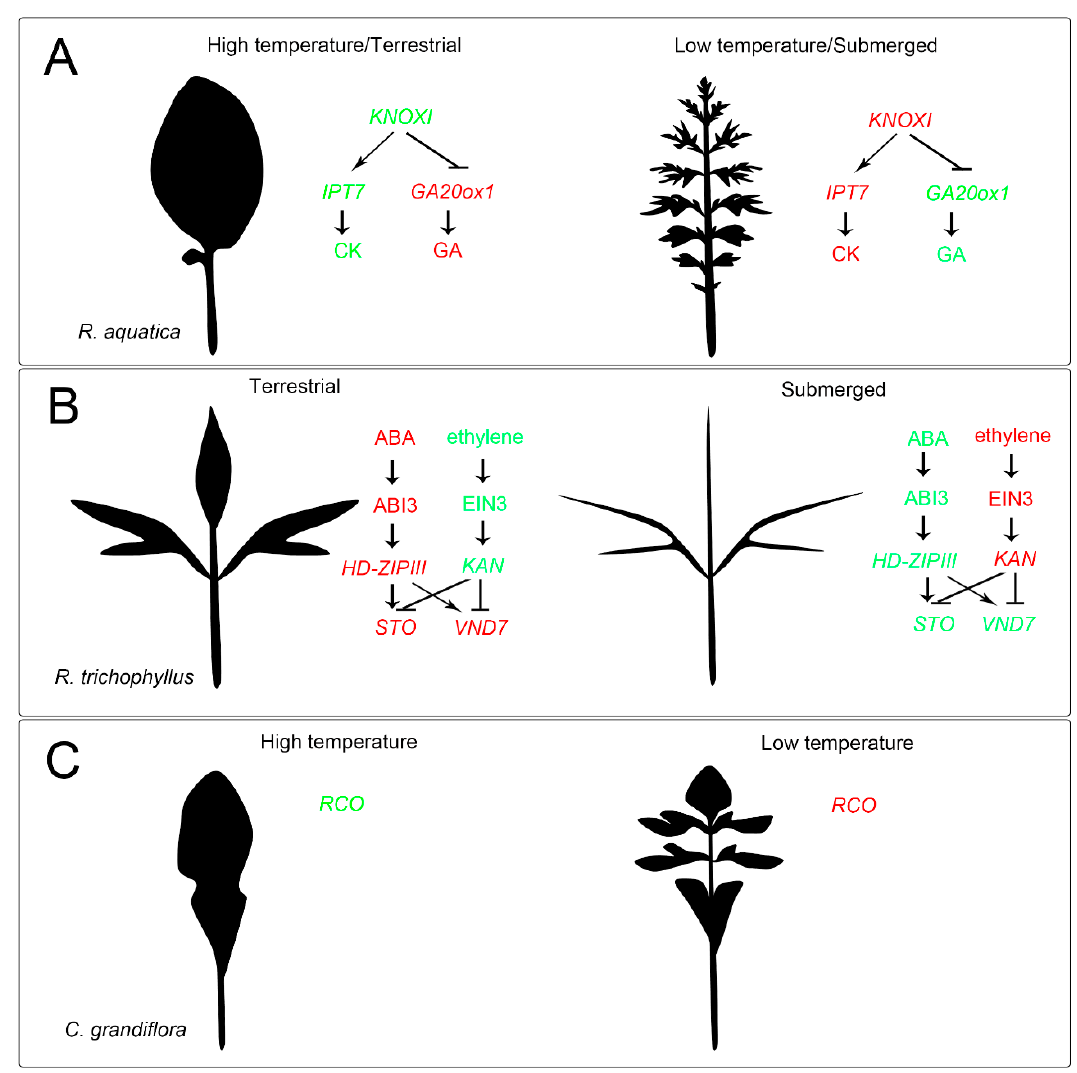
Figure 4. Molecular mechanisms of heterophylly. ( A ) The mechanism of heterophylly in R. aquatica . Complex leaves were induced by the upregulated KNOXI and thus induced repression of Ga20ox1 and downregulated GA, while simple leaves were induced by the downregulated KNOXI and thus induced upregulated Ga20ox1 and GA. KNOXI also induced the accumulation of CK by the regulation of ISOPENTENYLTRANSFERASE 7 ( IPT7 ). ( B ) The mechanism of heterophylly in R. trichophyllus . Terrestrial conditions induced ABA accumulation and activates HD-ZIPIII-mediated STOMAGEN ( STO ) and VASCULAR-RELATED NAC-DOMAIN 7 ( VND7 ) upregulation via ABI3, while submerged conditions induced ethylene accumulation and activate KAN-mediated STO and VND7 downregulation via EIN3 . ( C ) The heterophylly of C. grandiflora was induced by the temperature, dependent on REDUCED COMPLEXITY ( RCO ). Red in ( A – C ) represents upregulated genes or accumulated phytohormones, and green in (A–C) represents downregulated genes or phytohormones.